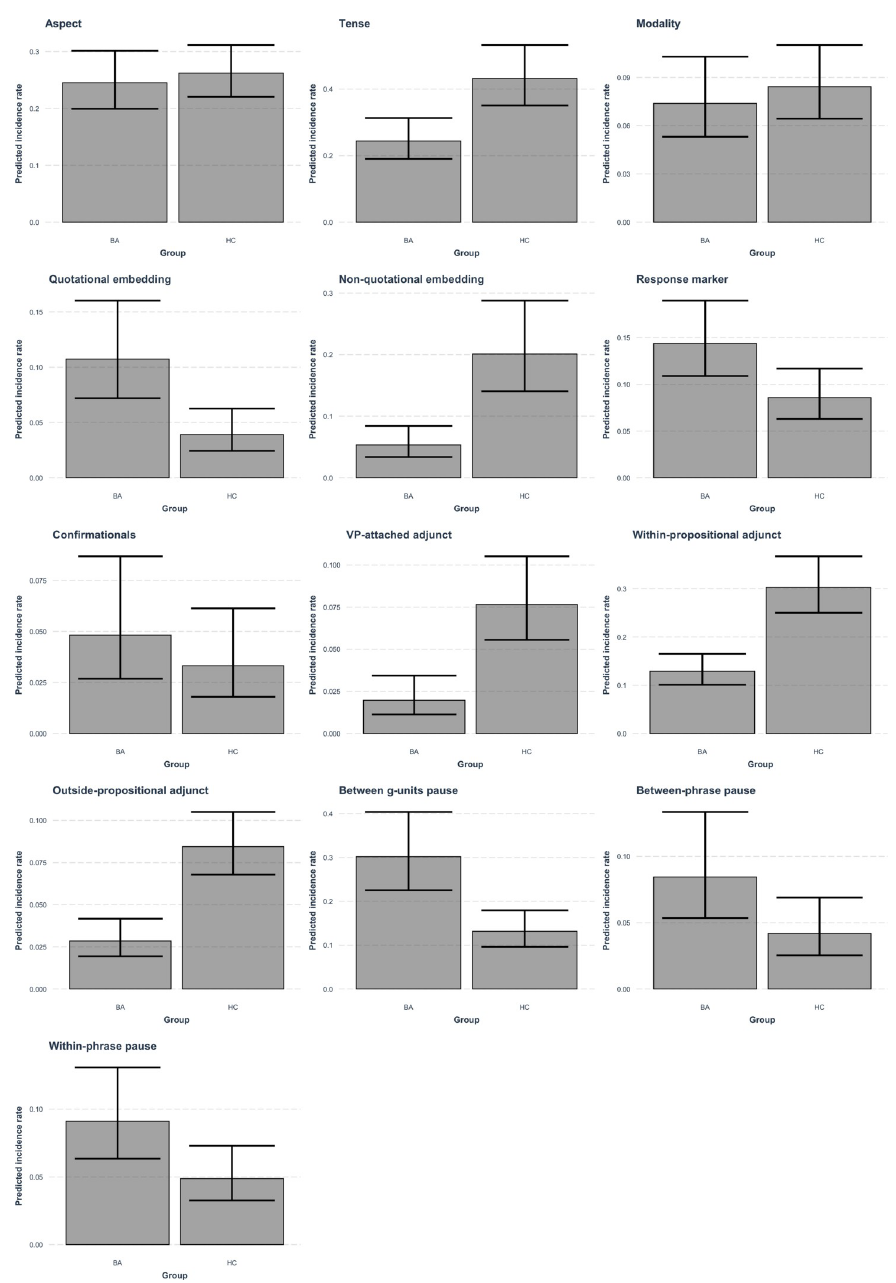
Fig 1. Estimated rates of the 13 linguistic variables for the two